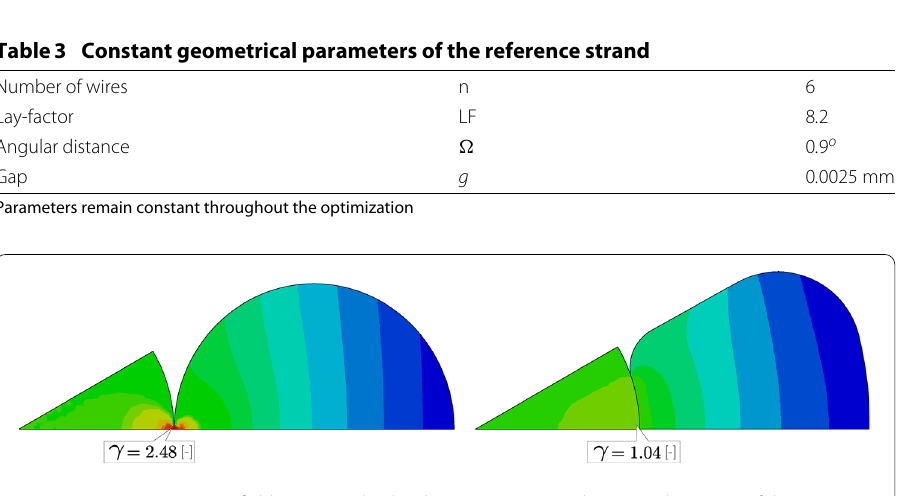
Fig. 9 Stress concentration field, computed as local stress over nominal stress at the center of the core wire. Because of the bending of the outer wire, a gradient is present. γ is dimensionless. Blue corresponds to the minimum value of 0 . 8 and red to the maximum value of 2 .